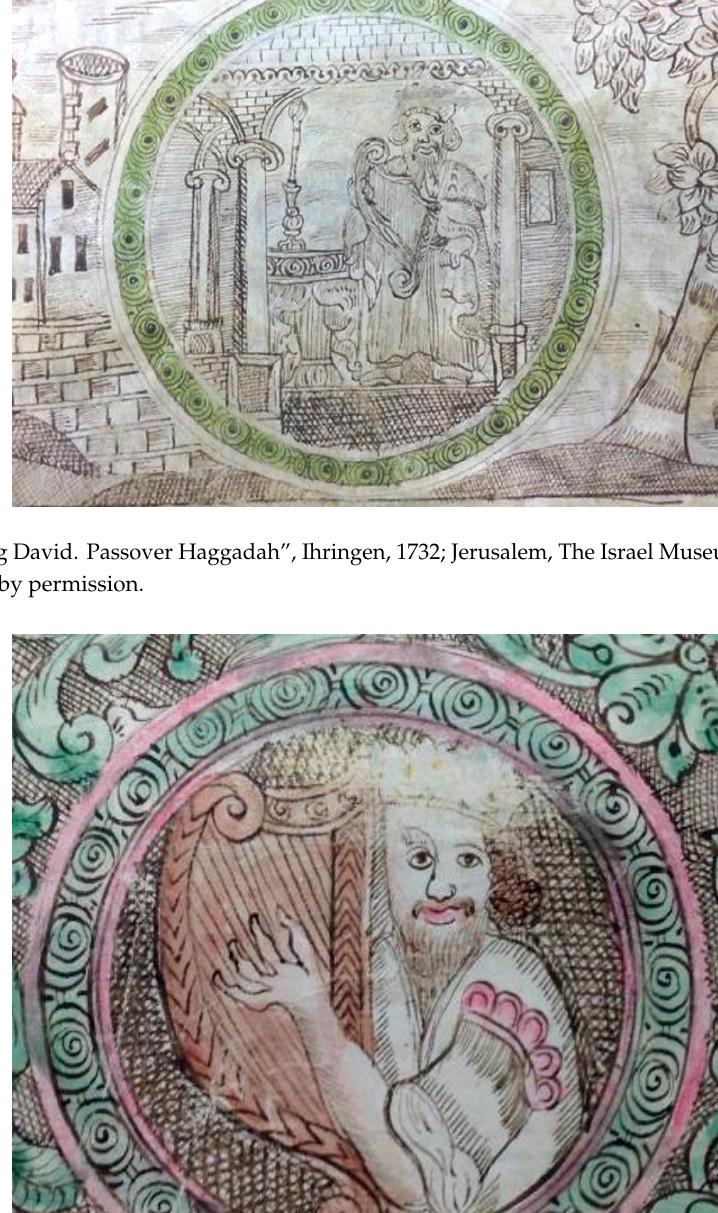
Figure 8. “Passover Haggadah”, Ihringen, 1732; Jerusalem, The Israel Museum, Ms. 181/48, Fol. 26v. Used by permission.